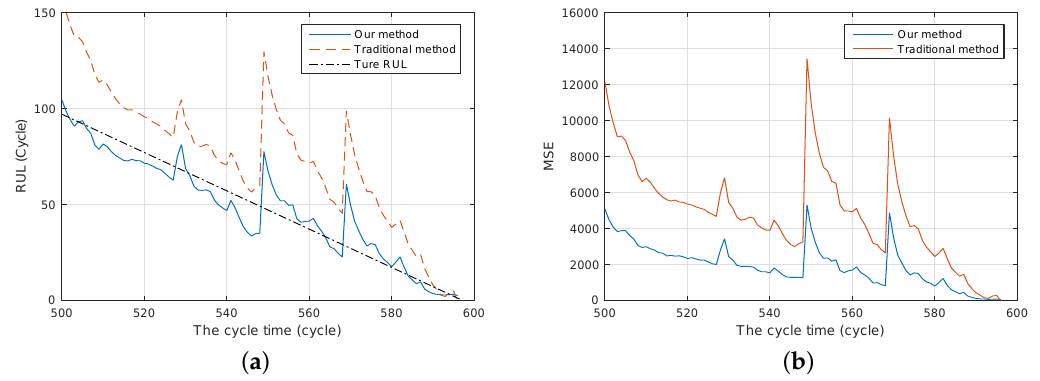
Figure 5. The comparison of the estimated RUL. ( a ) The comparison of expectation of RUL; ( b ) The MSE of estiamted